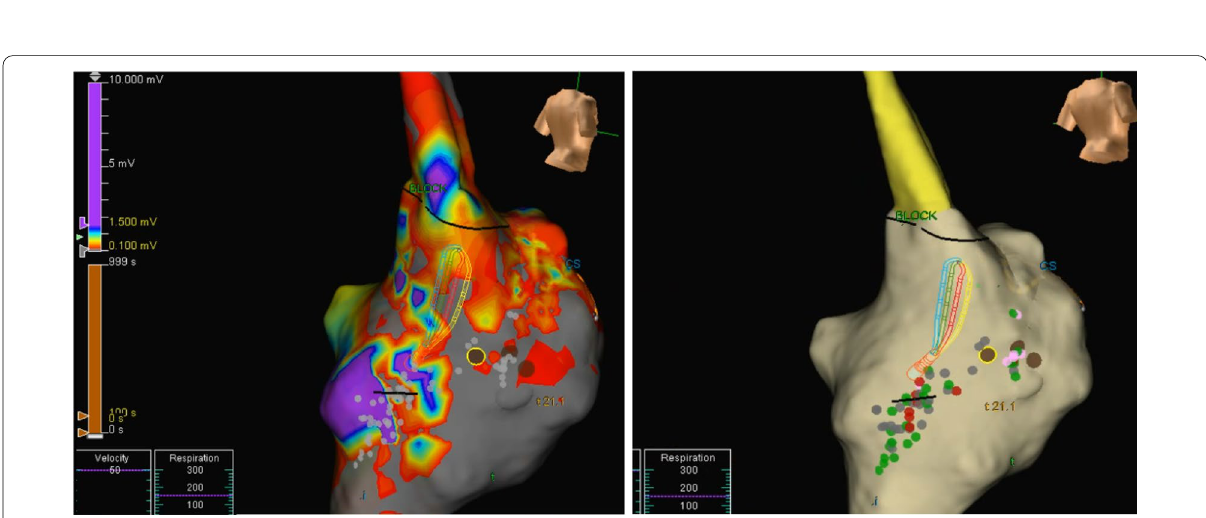
Fig. 3 The voltage mapping of the right atrium identified the tachycardia substrate in posterior inferior lateral wall of the right atrium which was successfully ablated. The patient had history of Tetralogy of Fallot required several surgical